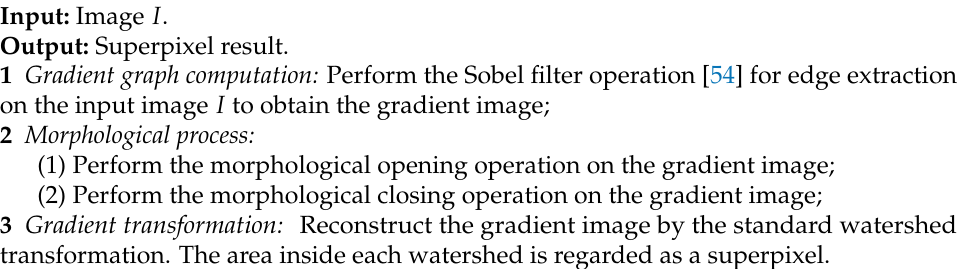
Algorithm 1 Watershed Segmentation